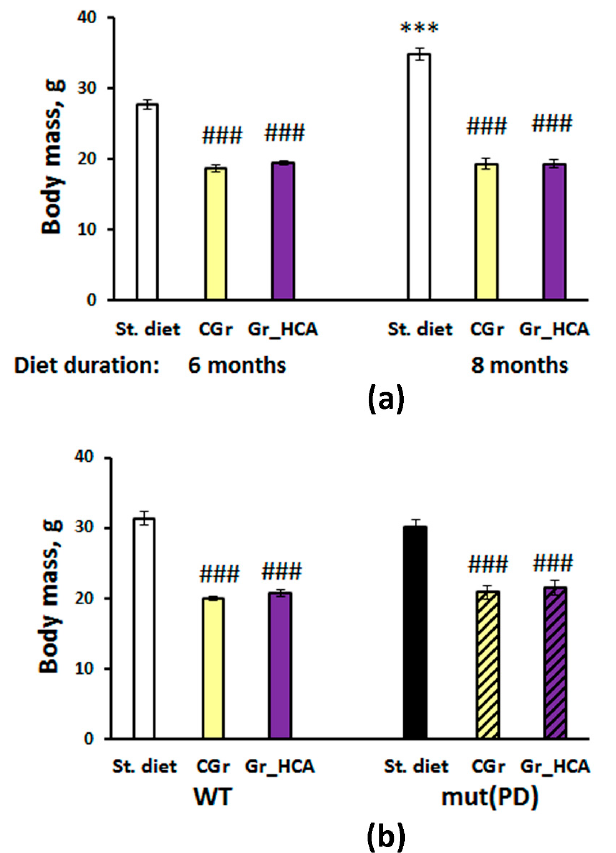
Figure 1. E ff ects of the type of diet and treatment duration ( a ) or of the type of diet and overexpression of α -synuclein (genetic Parkinson’s disease (PD) model) ( b ) on body weight gain in mice. Data are presented as the mean ± S.E.M. of the values obtained in an independent group of animals ( n = 6–15 per group). Statistically significant di ff erences: ### p < 0.001 vs. a respective group given the standard diet (St. diet); *** p < 0.001 vs. a respective group given the same type of diet for six